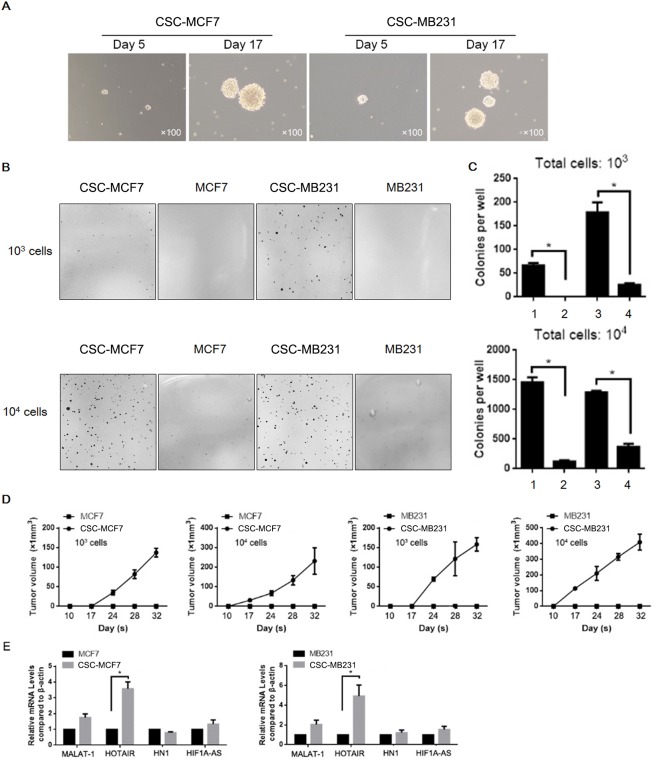
The level of HOTAIR expression in CSC-MCF7 and CSC-MB231 populations.(A) Enrichment of CSC subpopulations from MCF7 and MB231 cells were incubated and photographed on day 5 and day 17. (B) Colony formation by CSCs and their original cells on soft agar when seeded at 103 cells per well or 104 cells per well. (C) Colonies in each well were counted after staining with 0.05% crystal violet. (D) Tumor formation ability of CSCs or their original cells at different amounts was measured in mice, and the tumor volumes were measured from day 10 to day 32. (E) RT-qPCR measurement of the expression levels of MALAT-1, HOTAIR, HN-1 and HIF1A-AS in CSC-MCF-7 or CSC-MB231. *P<0.05.